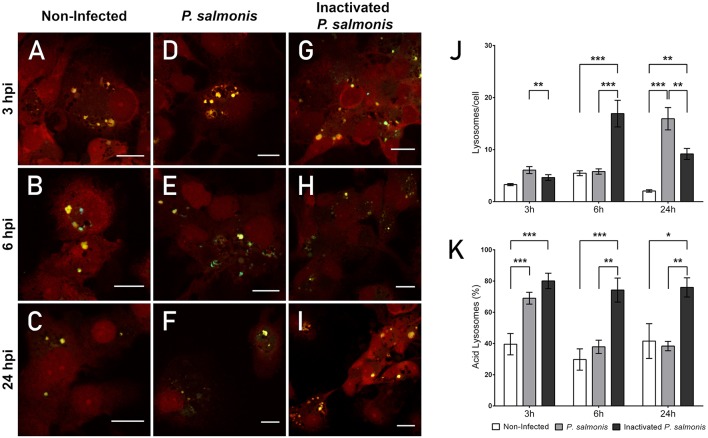
Lysosomal acidification in macrophage-enriched cell cultures infected with P. salmonis. Macrophage-enriched cultures obtained from Atlantic salmon head kidneys were incubated with P. salmonis at a MOI of 10 bacteria/cell and analyzed at 3, 6, and 24 hpi. The macrophage-enriched cell culture was treated with the LSYB probe (green and blue) to stain lysosomes and analyze their pH. The nucleus was stained with PI (red). (A–C) Non-infected macrophages analyzed at 3, 6, and 24 h. Macrophages-enriched cell culture incubated with P. salmonis for 3 h (D), 6 h (E), and 24 h (F). Macrophage-enriched cell culture incubated with inactivated P. salmonis for 3 h (G), 6 h (H), and 24 h (I). Scale bar: 10 μm (J,K). Lysosomal quantification in macrophage-enriched cell cultures infected with P. salmonis. Macrophage-enriched cell culture was infected with P. salmonis at a MOI of 10 bacteria/cell and analyzed at 3, 6, and 24 hpi. The lysosomes were stained with the LSYB probe and quantified as acidic lysosomes or neutral-basic (NB) lysosomes. The data were normalized to the number of cells analyzed. Non-infected macrophage-enriched cell culture and incubation with inactivated P. salmonis were used as controls for each time point. (J) Total number of lysosomes per cell. (K) Percentage of acidic lysosomes for each condition. The statistical analysis was performed through parametric ANOVA with a Dunnett's multiple comparison test. Significant differences: *p < 0.05, **p < 0.01, ***p < 0.001.